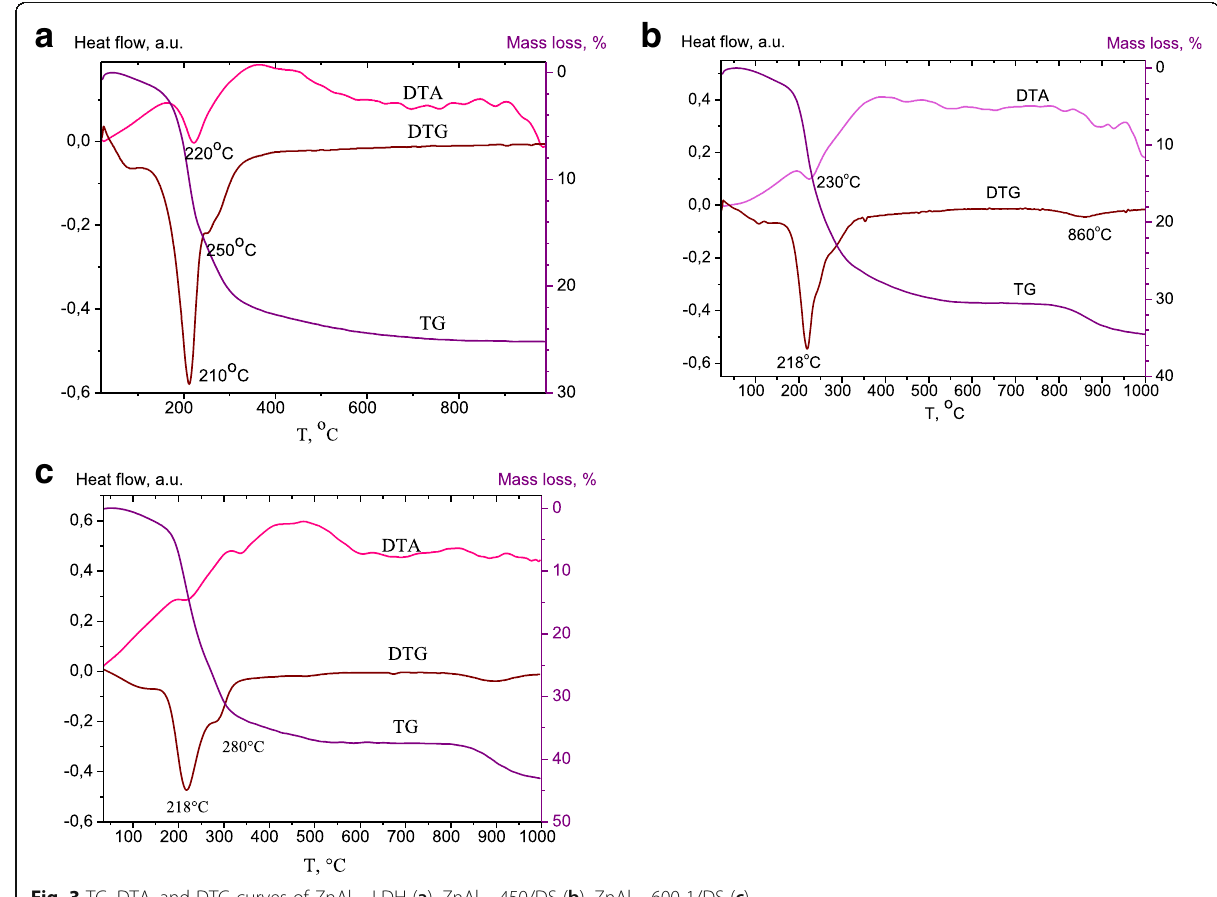
Fig. 3 TG, DTA, and DTG curves of ZnAl 41 LDH ( a ), ZnAl 41 -450/DS ( b ), ZnAl 41 -600-1/DS ( c